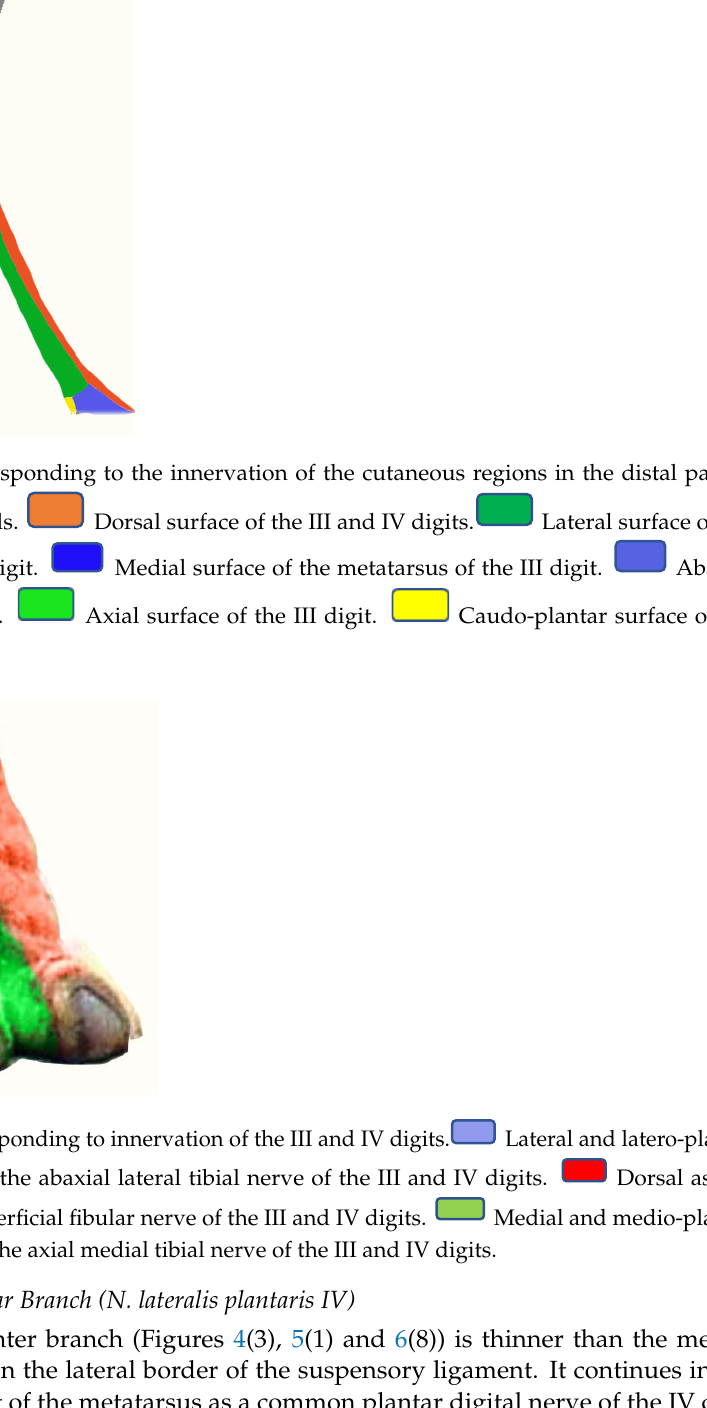
abaxial aspect of the lateral IV digits and supplying the plantar-abaxial aspect of the IV digit, ending at the foot pad. The lateral plantar nerve ( N lateralis plantaris IV ) supplies the plantar-abaxial aspect of the fourth digit’s skin (Figures 9 and 10). The superficial fibular nerve contributes to the nerve supply of the skin of the dorsal surface of the metatarsus region. In addition, the terminal branches of the superficial fib- ular nerve supply the dorsal surface of the axial and abaxial aspects of the third and fourth digits (Figures 9 and 10). The numerous twigs of nerve branches of the caudal sural cutaneous nerve from the tibial nerve involve the lateral and plantar aspects of the leg to the metatarsus and digits innervation along its extension to the skin of the plantar surface of the metatarsus (Figure 6). In addition, the terminal twigs supply the axial and abaxial plantar aspects of the third and fourth digits, as well as the interdigital surface of the digits (Figures 9 and 10). The numerous twigs of nerve branches contribute to the saphenous nerve in the dorsomedial aspect of the leg to the metatarsus and digit innervation, which also contributes with branches to the III and IV digits, along with the I and II digits. 4. Discussion The nerves that supply the innervation of the leg and pes of camels are the saphenous, superficial fibular, tibial, caudal cutaneous sural and lateral cutaneous sural nerves, which